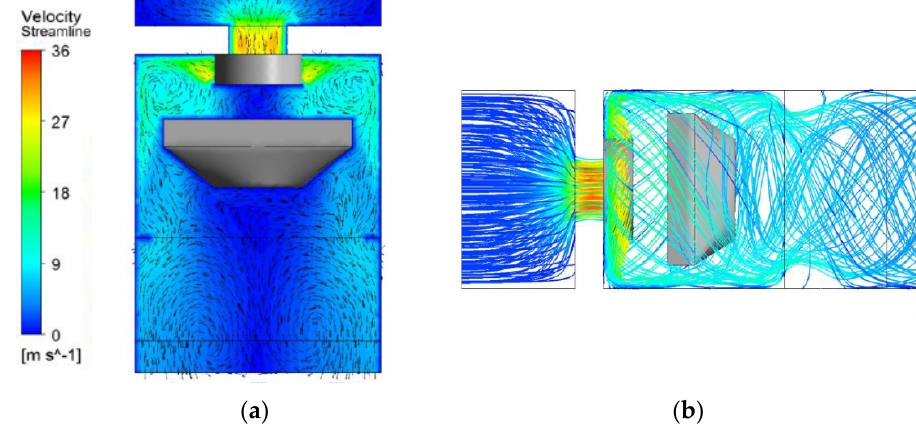
Figure 11. Velocity field inside the AHU with the FCU optimized: ( a ) velocity contour and velocity vectors at medium height and ( b ) velocity streamlines inside the AHU.